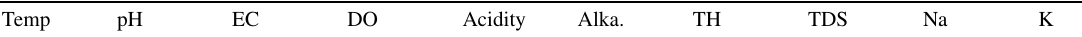
Table 1 Pearson correlation matrix of pre-monsoon water